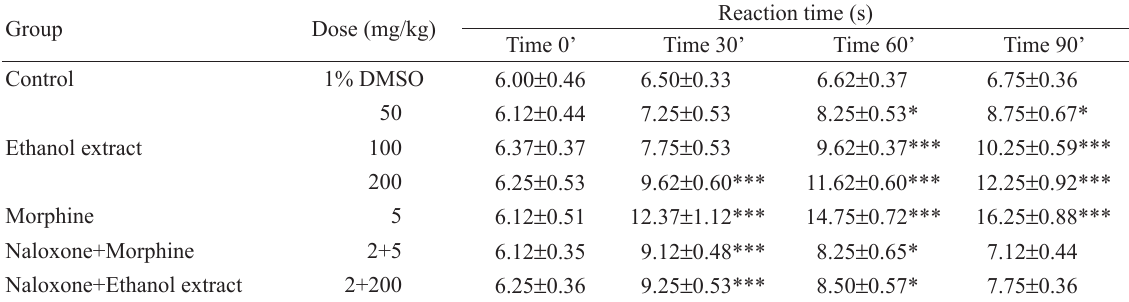
Data are mean ± S.E.M. of 8 mice. * p < 0.05; *** p < 0.001 vs control